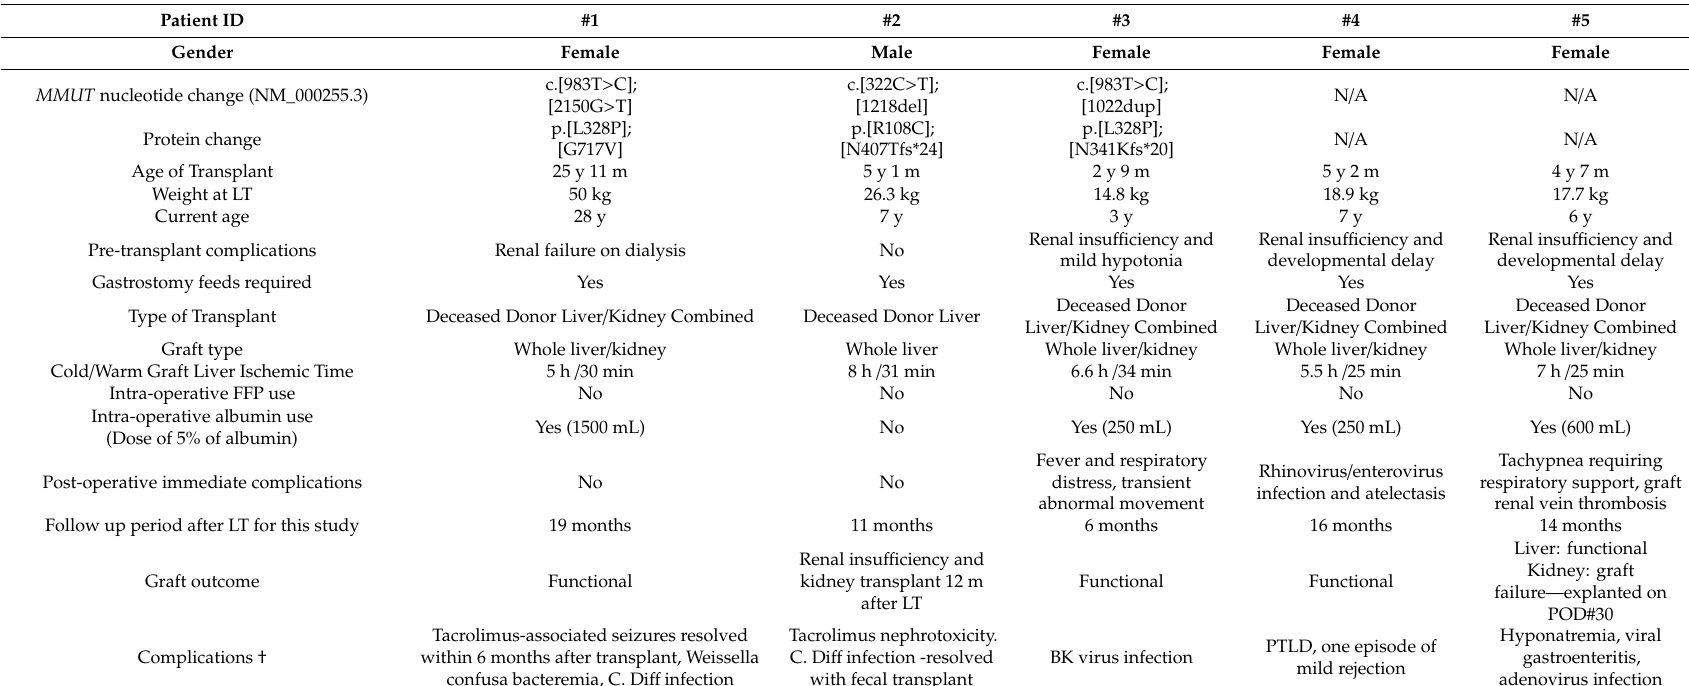
Table 1. Patient Demographics and Clinical Information.